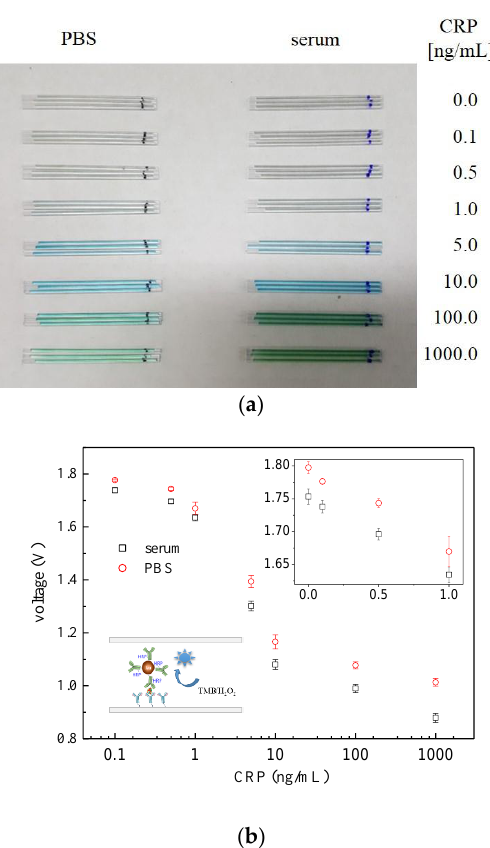
Figure 5. ( a ) Picture of the capillary tubes that had undergone “AuNP capillary ELISA” either under PBS or serum, and ( b ) their logarithmic plot of optical density expressed in voltage against CRP concentration with the inset representing linear plot in the lower concentration range.